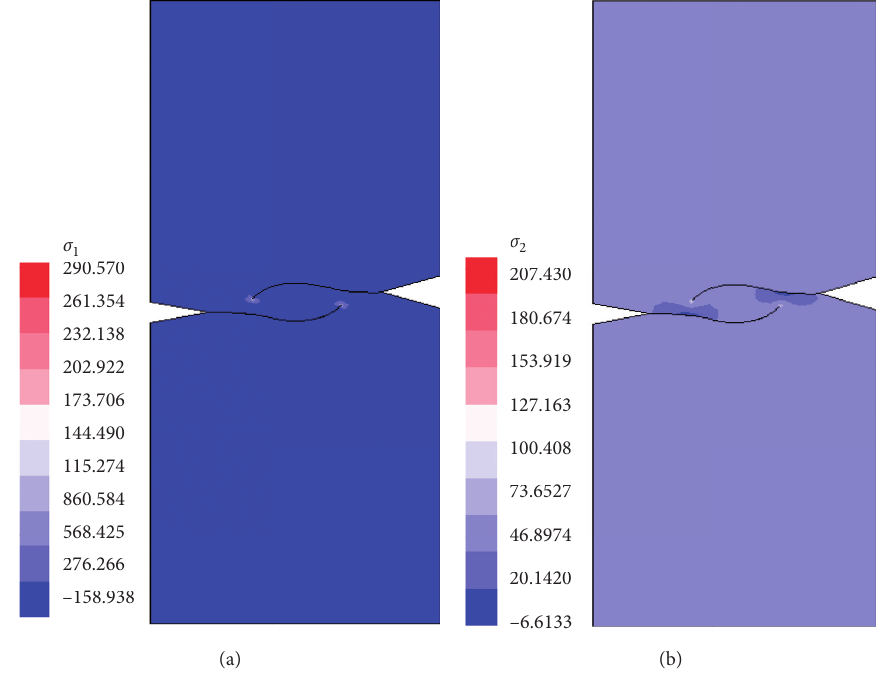
Figure 17: (a) Maximum principal stress. (b) Minimum principal